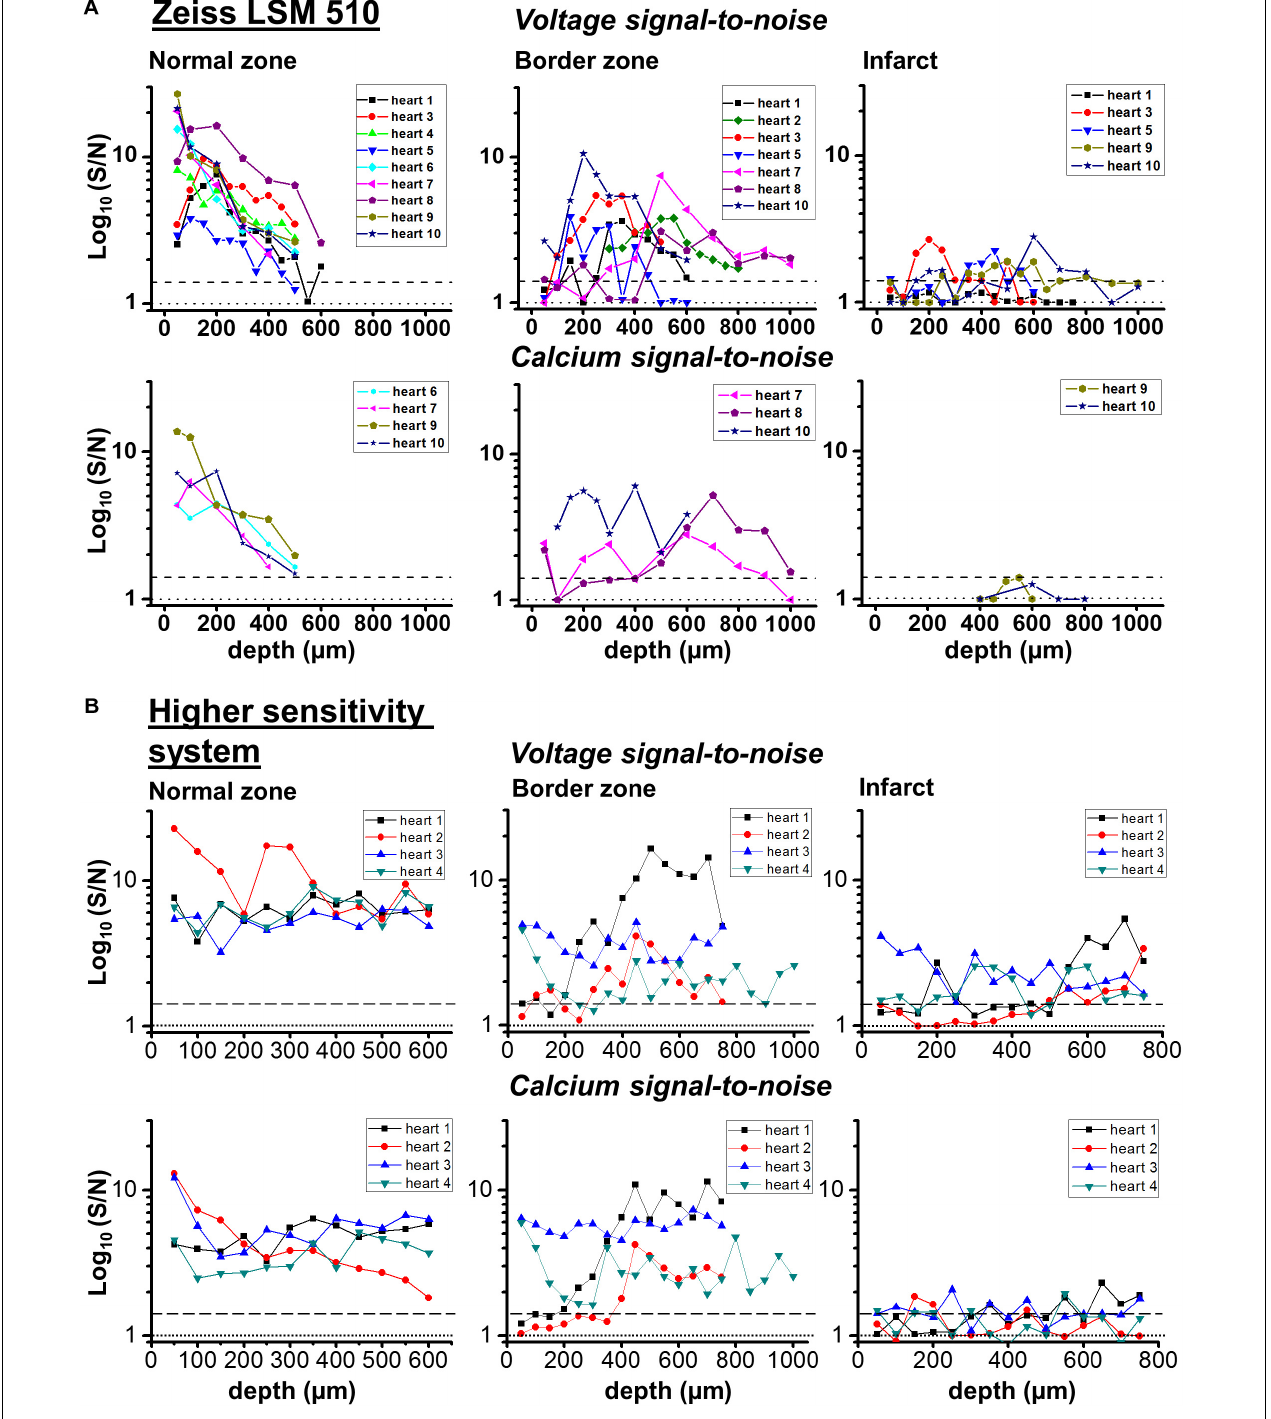
FIGURE 8 | Transmural signal-to-noise in remote, border zone and infarct regions – voltage vs. calcium. S/N values (log10) for voltage (upper row) and calcium (lower row) as a function of tissue depth for individual hearts in two microscope systems: (A) Zeiss LSM 510 and (B) microscope system featuring optimized detection and optical configuration. From right to left; remote myocardium; border zone; infarct. For border and infarct zones, traces are displayed from hearts which demonstrated significant S/N ( > 1.4) constituting detection of a signal. Dashed line for each graph indicates threshold for signal detection.